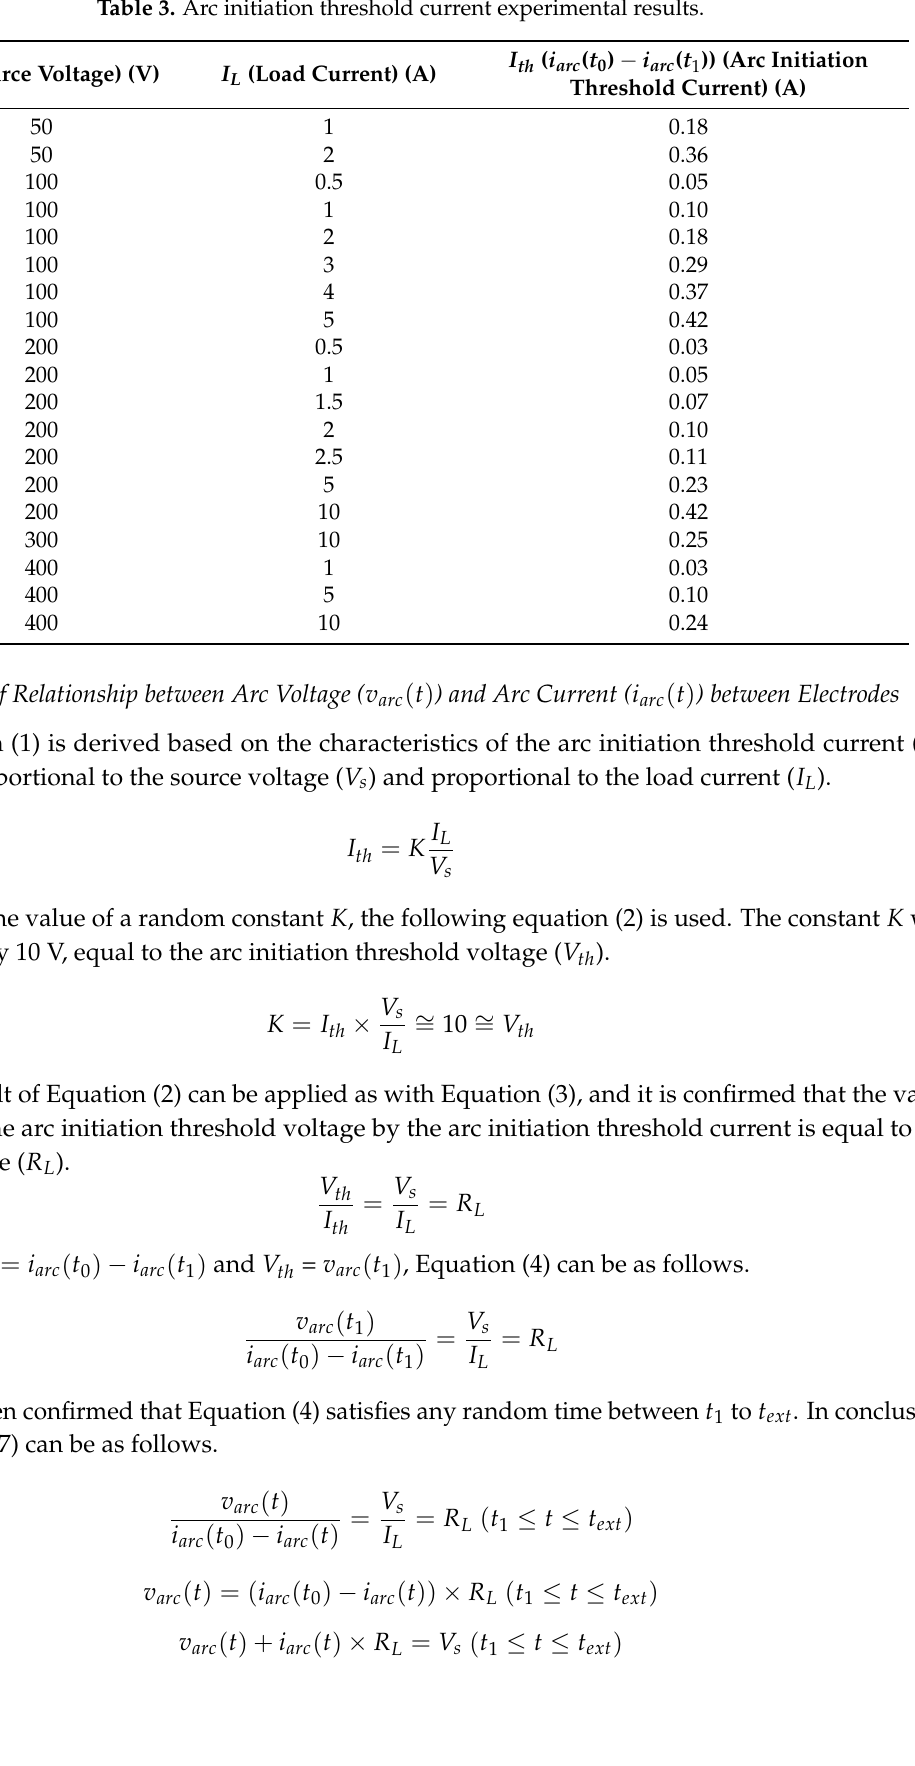
Table 3. Arc initiation threshold current experimental